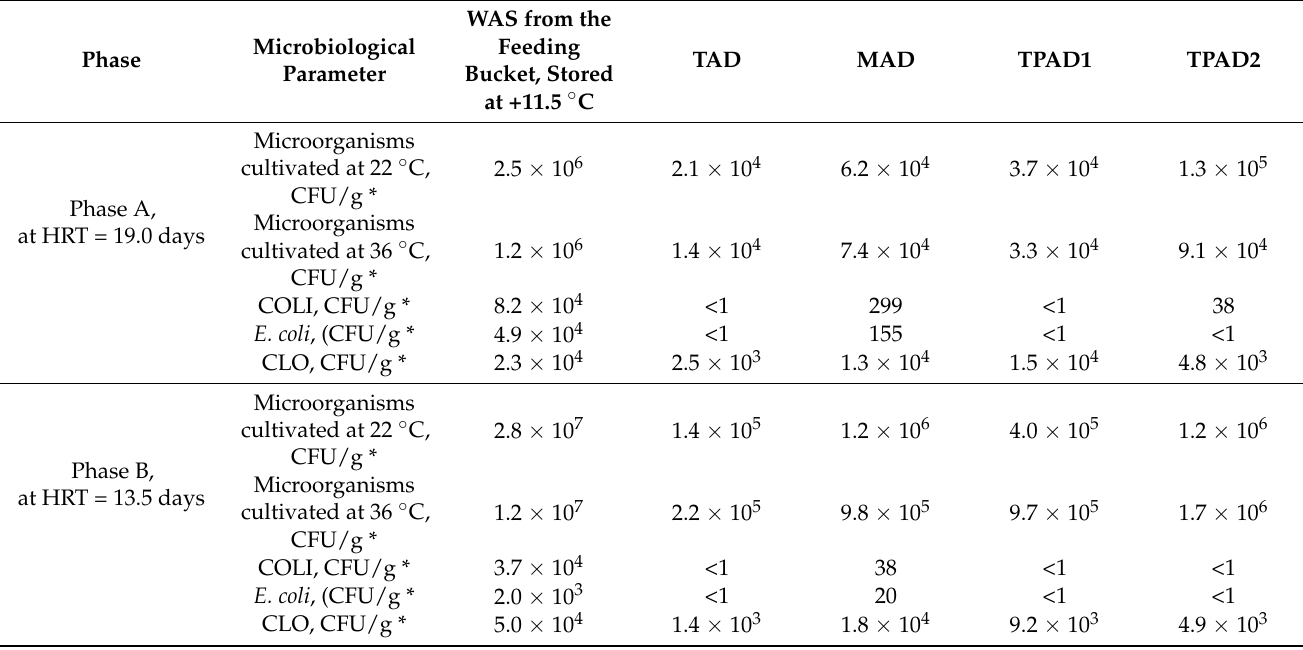
Table 11. Microbiological characterization of the digested sludge concerning the pathogenic